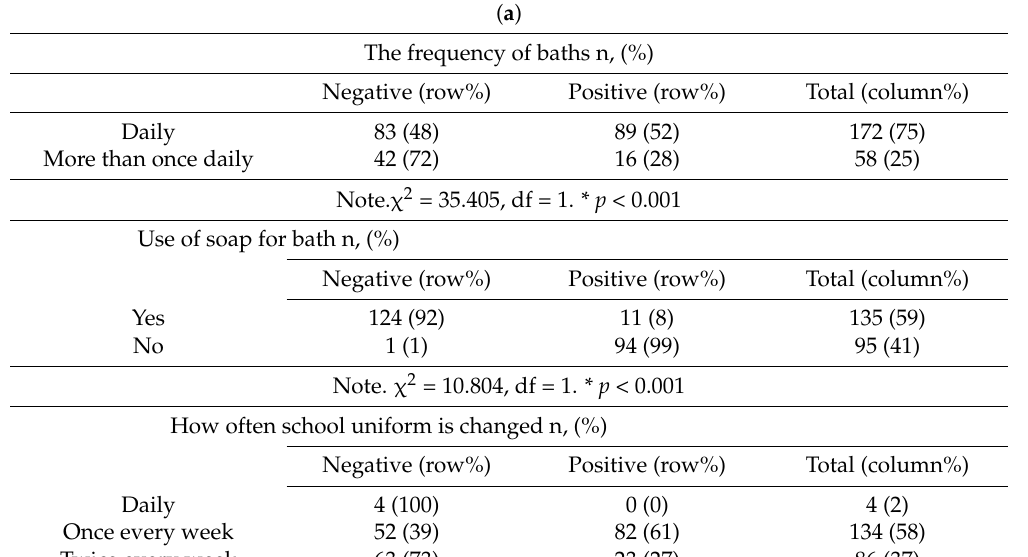
Table 3. Chi-square test of independence between the independent variables and the occurrence of tinea capitis. ( a ) Risk Factors Associated with the Occurrence of Tinea Capitis among All the Participants; ( b ) Risk Factors Associated with the Occurrence of Tinea Capitis among All the Participants, Based on Socio-Demographic